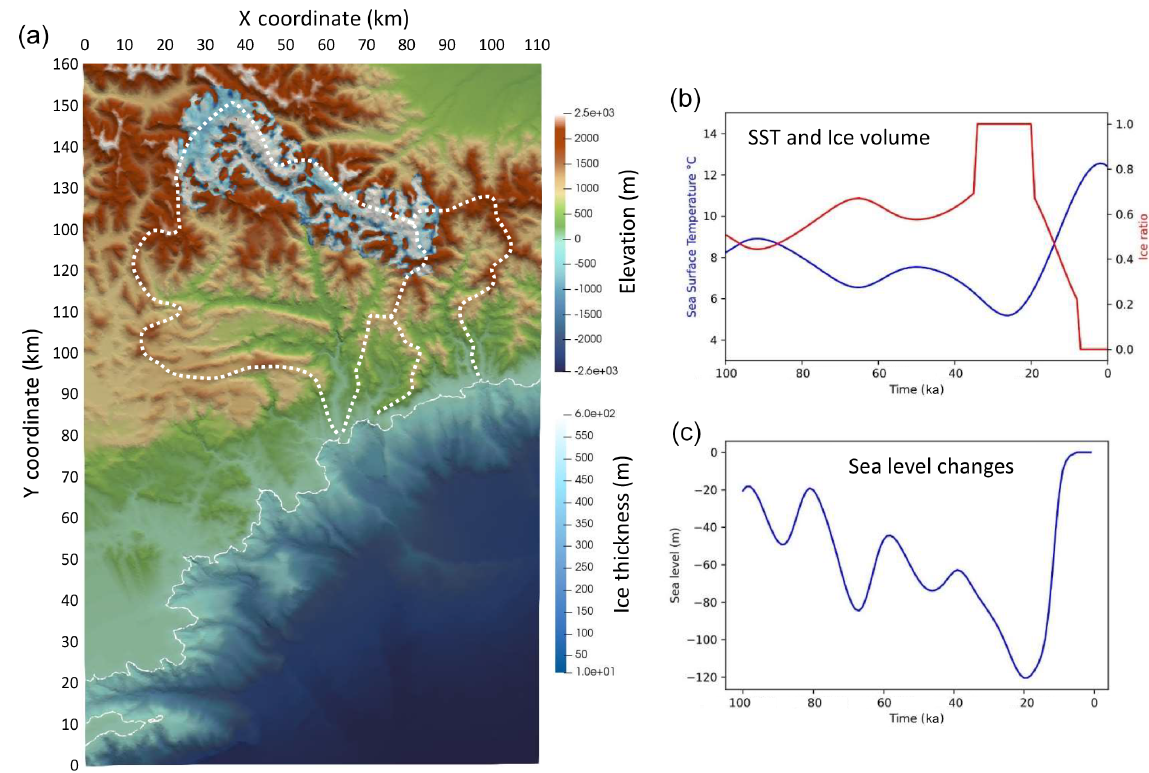
Figure 3. (a) Topography, bathymetry and maximum ice thickness (after Brisset et al., 2015) and contour of the main catchments (dashed line); (b) smoothed variations in the sea surface temperature (SST; after Hayes et al., 2015, and Rodrigo-Gamiz et al., 2013) in blue and ice thickness ratio (1 is for full ice, 0 for no ice) in red; (c) sea level variations (after Waelbroeck et al., 2002). Table 1. Sea level high-latitude parameters for 10 Be production (after Braucher et al., 2011). Neutron Slow muon Fast muon Neutron Slow muon Fast muon Radioactive Density spallation capture capture attenuation attenuation attenuation decay rate rate rate length length length constant at.g − 1 yr − 1 at.g − 1 yr − 1 at.g − 1 yr − 1 gcm − 2 gcm −